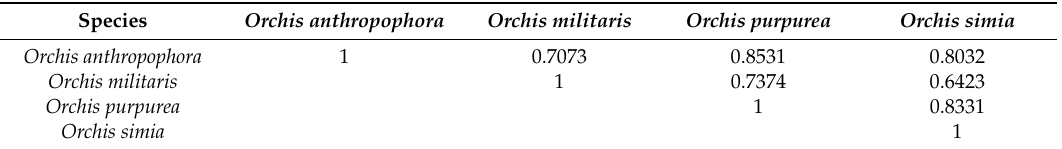
Figure 3. Current and predicted area of suitable habitat in 2050 for the four Orchis species under three di ff erent climate change scenarios (RCP (Representative Concentration Pathway) 2.6, RCP 4.5 and RCP 8.5). Table 2. Overlap in the ecological niche between each Orchis species pair. Values closer to one indicate more similar habitat